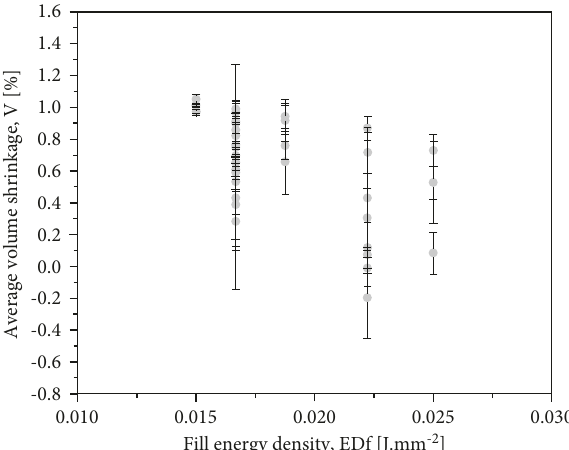
Figure 6: Effect of fill energy density on the average volume shrinkage of flexion samples.